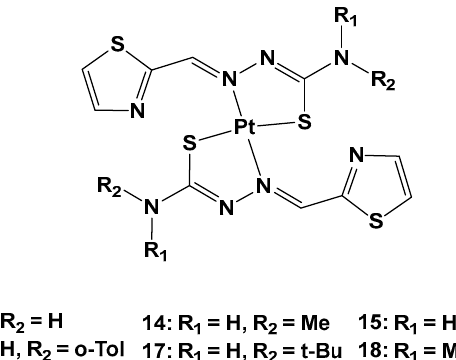
Figure 9. Series of new Pt complexes, 13 – 18 .